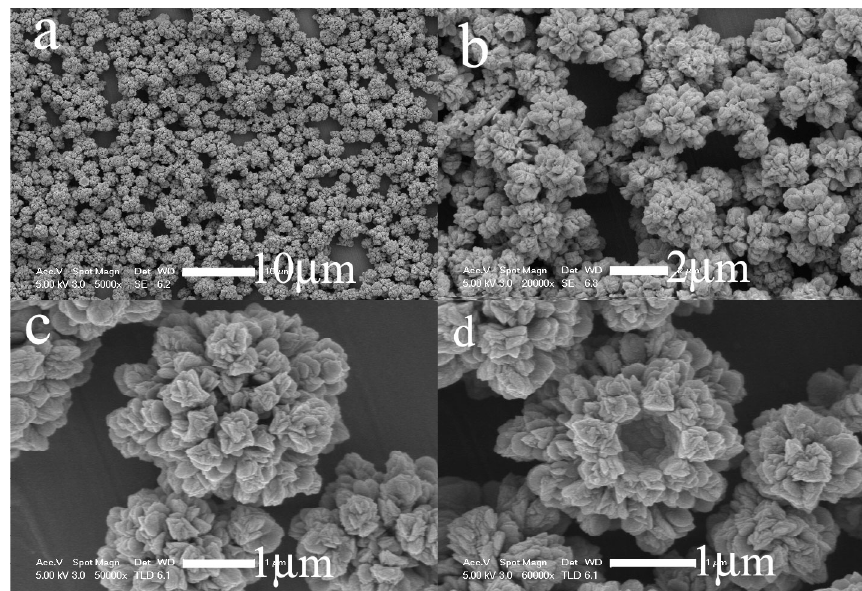
Figure 2. FESEM images of the flower-like CdS architectures obtained at 160 o C for 12 h: (a) and (b) low magnification FESEM images; (c) and (d) high magnification FESEM (Figs. 2a and 2 b) confirm the large-scale production of uniform 3D flower-like architectures with diameters of 1.8-3 µm, and the yield is almost 100%. In order to calfiry the CdS structures, high-resolution FESEM images, as shown in Fig. 2 c clearly reveal that the flower-like CdS architectures are assembled by some smaller grains. In addition, it can be seen that the CdS architectures are hollow structures from Fig. 2d.